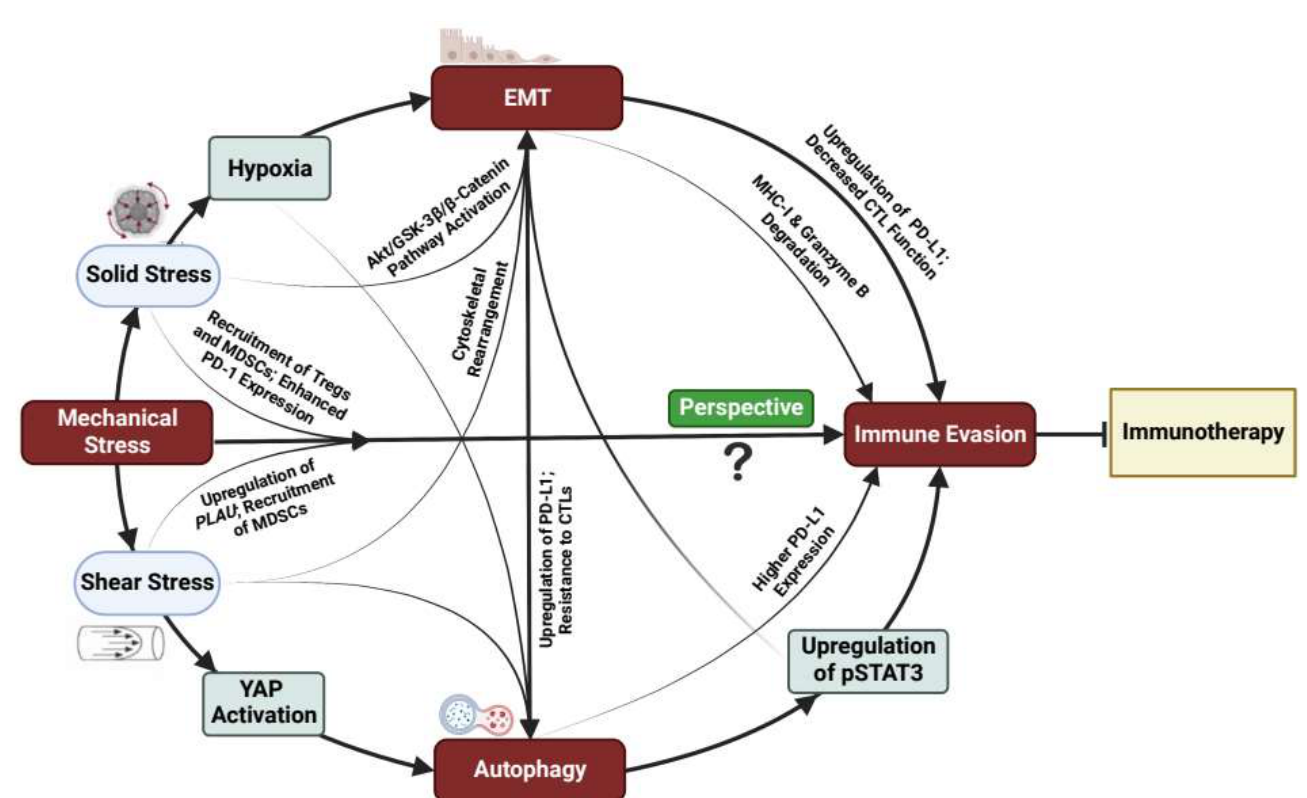
Figure 1. The physical and biological characteristics of tumors and their microenvironment interact to influence immune evasion and immunotherapy outcomes. Mechanical stress (solid and fluid) can exert both direct and indirect effects to promote immune evasive mechanisms. In tumors, solid stress (compressive and tensile) collapses tumor blood vessels, causing hypoxia within the TME,